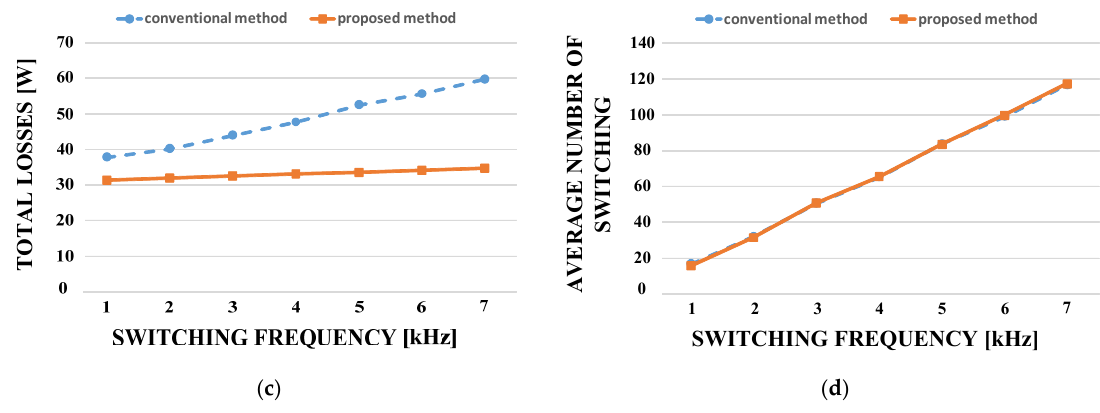
Figure 5. Comparative results obtained by the proposed method and the conventional method vs.